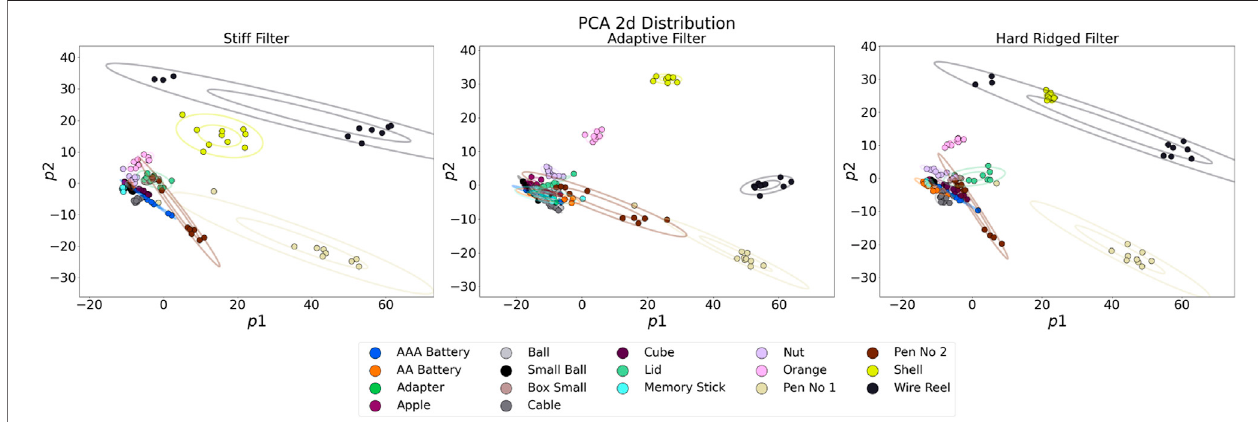
FIGURE 9 | 2D projections of the PCA analysis of the sensor response for the experiments when performed with the three different fi lters (stiff, adaptive, and hard ridged).